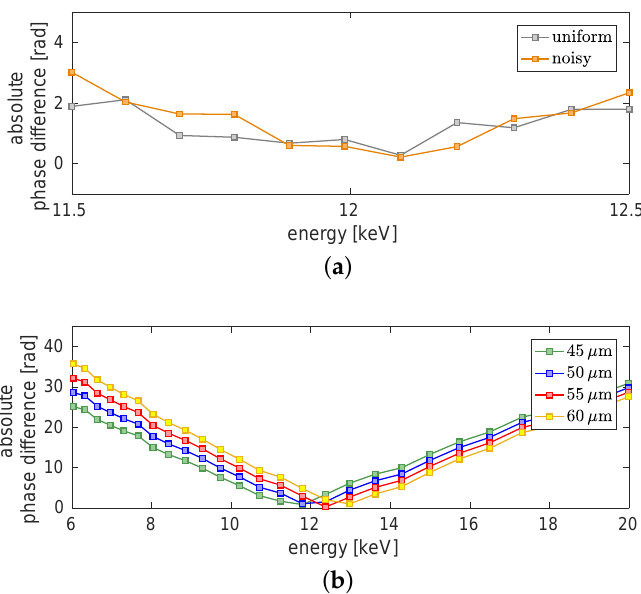
Figure 5. Absolute difference between the mean phase-shift of the green region of interest and the theoretical value depending on the energy. ( a ) The grey curve results from the reconstruction process with a uniform reference and the orange curve from a noisy reference with NL = 31.81dB. ( b ) Results for different assumed diameters of the titanium wire. The blue curve presents the result shown in Figure 4 for the given value of the diameter of 50 µ m. In green, red and yellow the absolute phase difference for a theoretical phase-shift of a 45 µ m, a 55 µ m and a 60 µ m wire is shown, respectively. The error is in the regime of